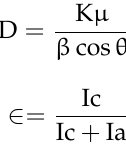
Figure 2. ( a ) TEM and ( b ) HRTEM images of Si@EG, ( c ) TEM and ( d ) HRTEM images of Si@EG@p- PANI composites.